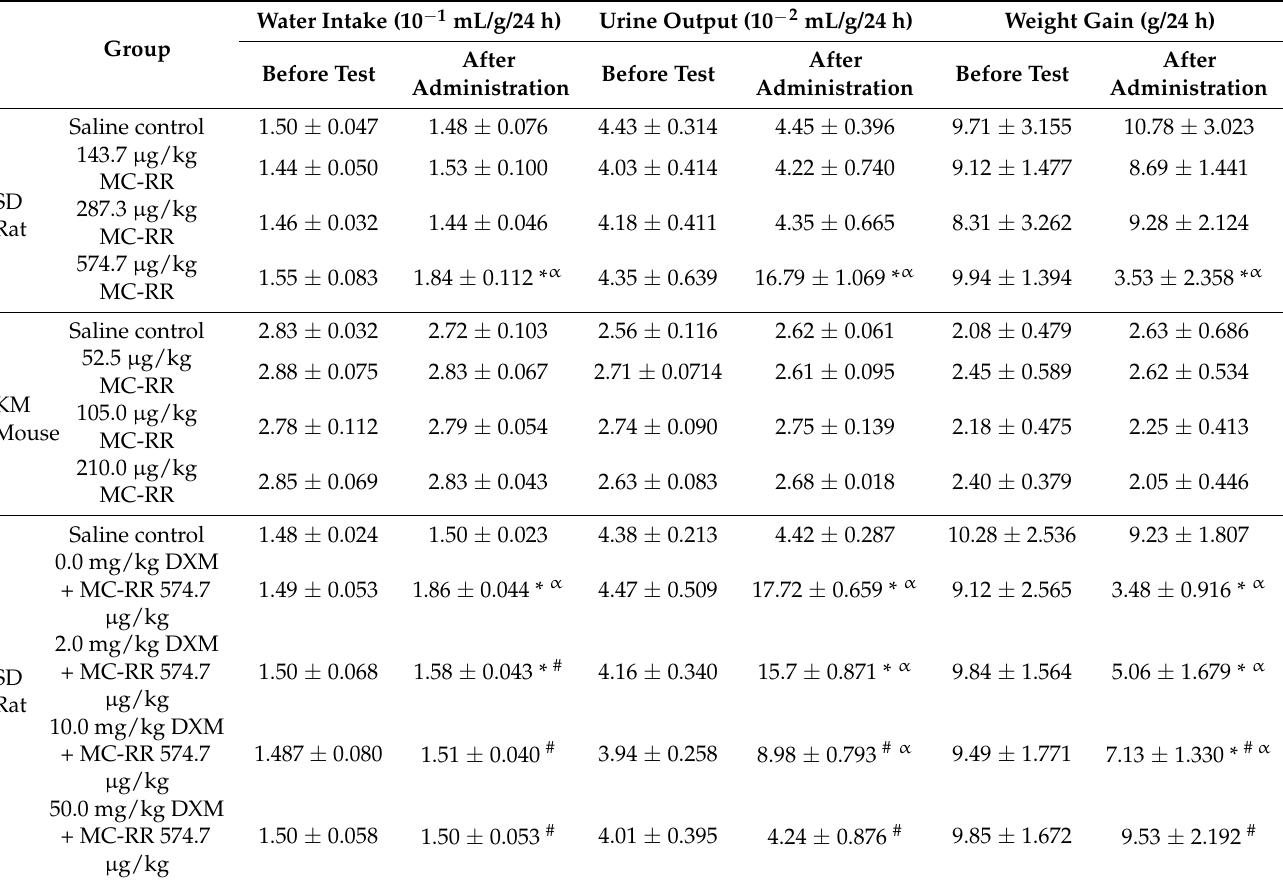
Table 1. Water intake, urine output and weight gain of Sprague–Dawley (SD) rats and KunMing (KM) mice treated with microcystin-RR (MC-RR) in single-dose experiment (mean ± SD, n = 6). Weight Gain (g/24 h) After After After Before Test Before Test Before Test Administration Administration